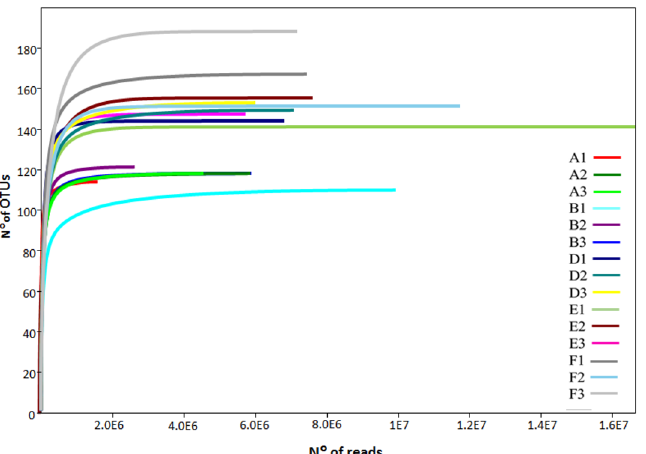
Figure 1. Rarefaction curves of the OTU numbers at 97% similarity for each sample. In the legend, numbers indicate replicates (1, 2, 3) and letters the number of seeds analyzed (A = 100, B = 200; D = 600, E = 800; F = 1000